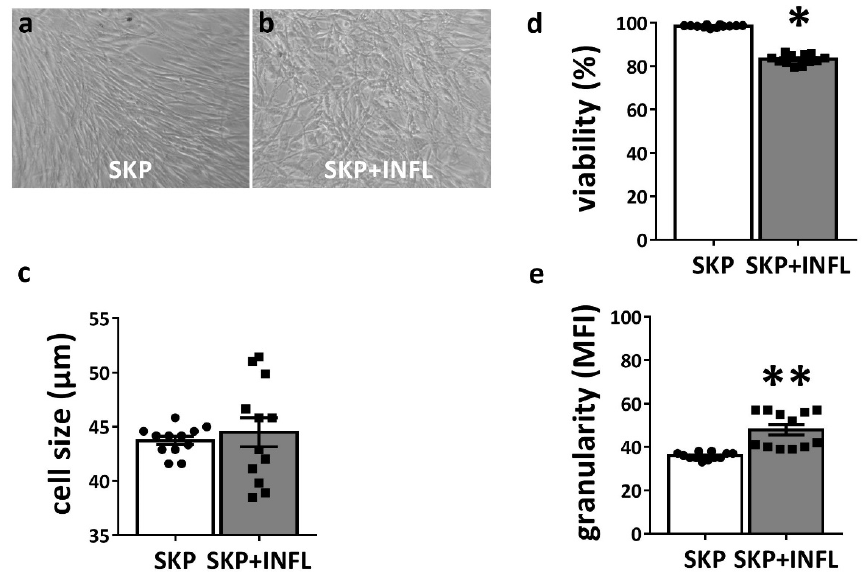
Figure 1. Impact of inflammation on biological properties of SKP. SKP preserve ( a , b ) their fibroblast-like morphology, but show ( c ) increased variation in cell size upon pro-inflammatory stimulation. The ( d ) viability and ( e ) granularity of SKP are determined under normal and inflammatory conditions. The values are expressed as mean ± SEM of four different SKP donors. * Significantly decreased versus SKP ( p -value < 0.0001); ** Significantly increased versus SKP ( p -value < 0.0001). Whole transcriptome and secretome analyses reveal that pro-inflammatory stimulation significantly alters the expression of chemokines, cytokines and growth factors in SKP (Figure 2a–g;